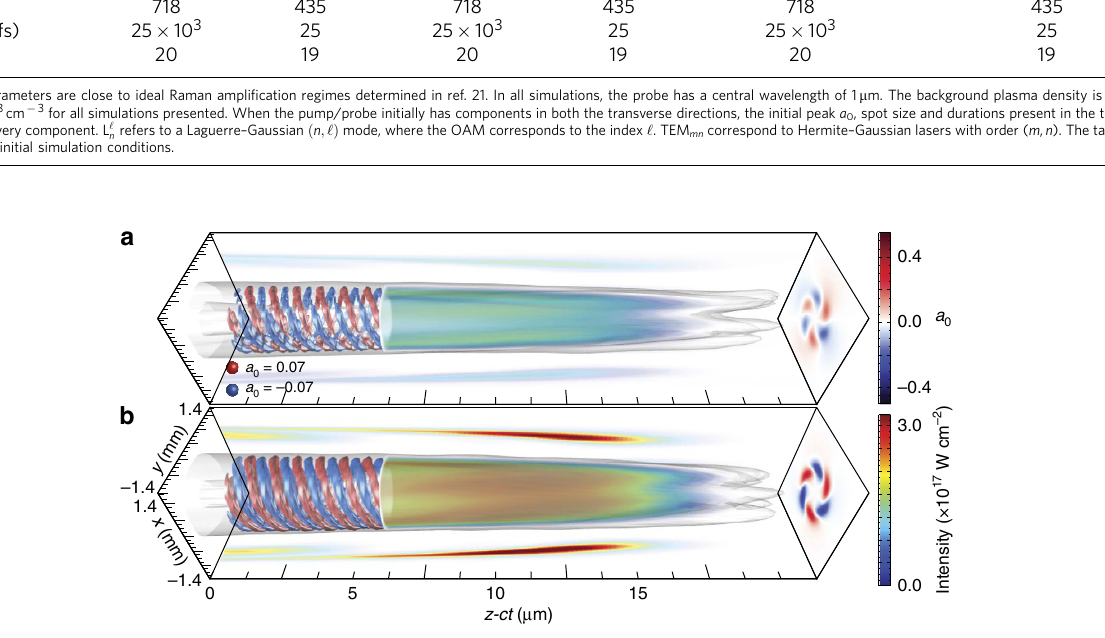
Figure 3 | Simulation results showing the generation and amplification of a new OAM modes. The new mode with ‘ 1 y ¼ 3 grow from a seed with ‘ 1 x ¼ 1 and a linearly polarized pump with a Gaussian profile in the x direction, and with an OAM ‘ 0 y ¼ 2 in the y direction. z ¼ 2mm ( a ) and z ¼ 6.22mm ( b ). The initial set-up is illustrated in Fig. 1b. Projections in the ( x , z-ct ) and ( y , z-ct ) planes show intensity profile slices at the mid-plane of the OAM mode (blue–green–red colours). Projections in the ( x , y ) plane (blue–white–red) show the normalized vector potential ( a 0 ) field envelope of the new OAM mode at the longitudinal slice where the laser intensity is maximum. The envelope of the 3D laser intensity is also shown for z 4 6.25mm in blue–green–red colours, and normalized vector potential isosurfaces for z o 6.25mm in blue and red.